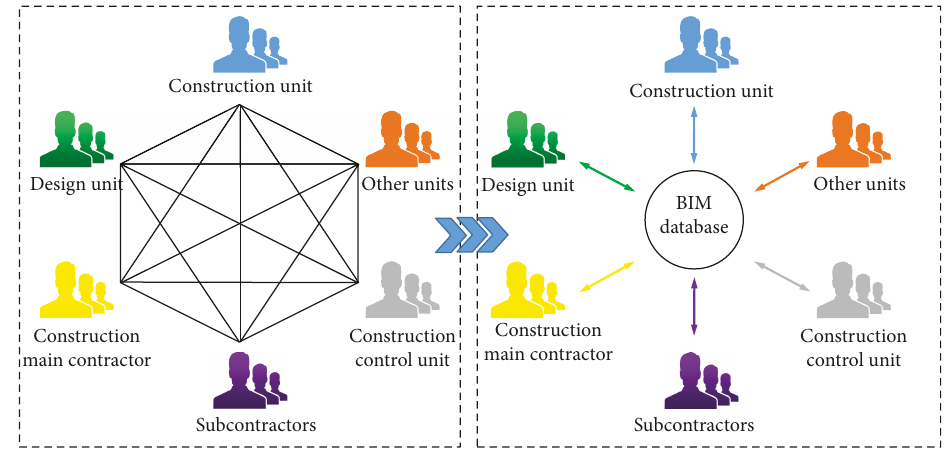
Figure 1: Changes in the mode of information